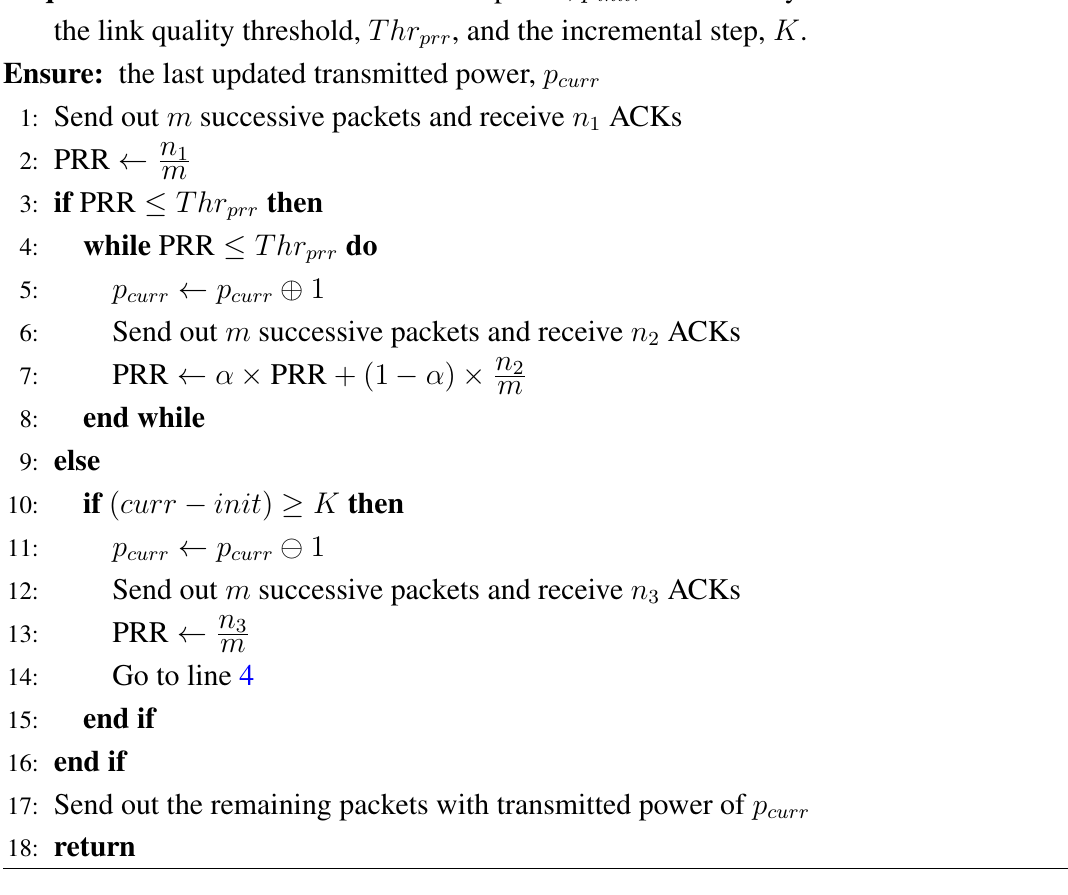
Algorithm 1 Link quality adaptive transmitted power